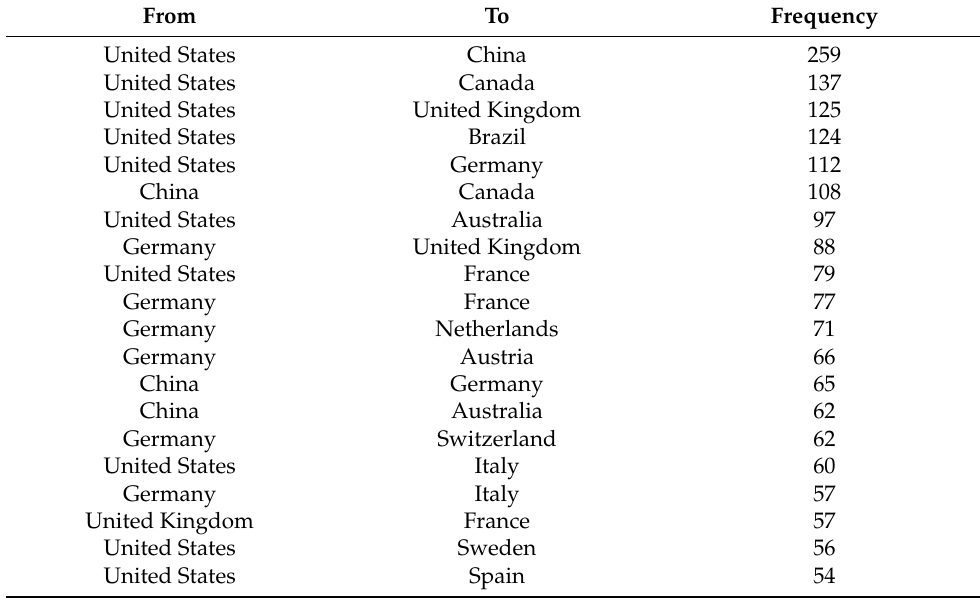
of temperate and boreal forests, either directly (through forest management) or indirectly (through nitrogen deposition) [22].